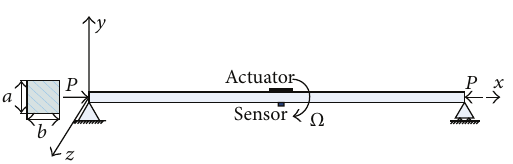
Figure 2: Spinning flexible beam